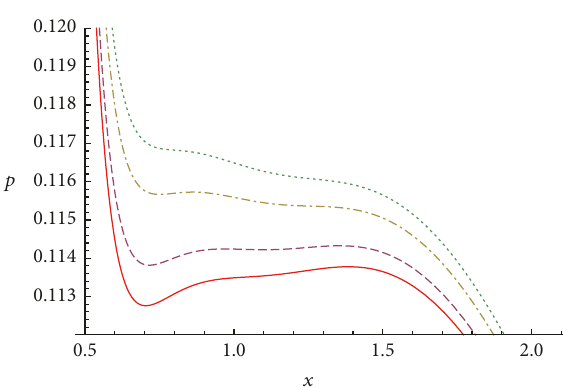
Figure 7: Behavior of 𝑝 as a function of 𝑥 for 𝑡 = 0.495, 0.497, 0.4988 , and 0.5 from bottom to top. For small pressure, one can see that there are stable SBH and LBH branches, which implies the occurrence of VdW-like phase transition. With the increasing of the temperature, there appears a new stable IBH branch. Further increasing the pressure, this branch